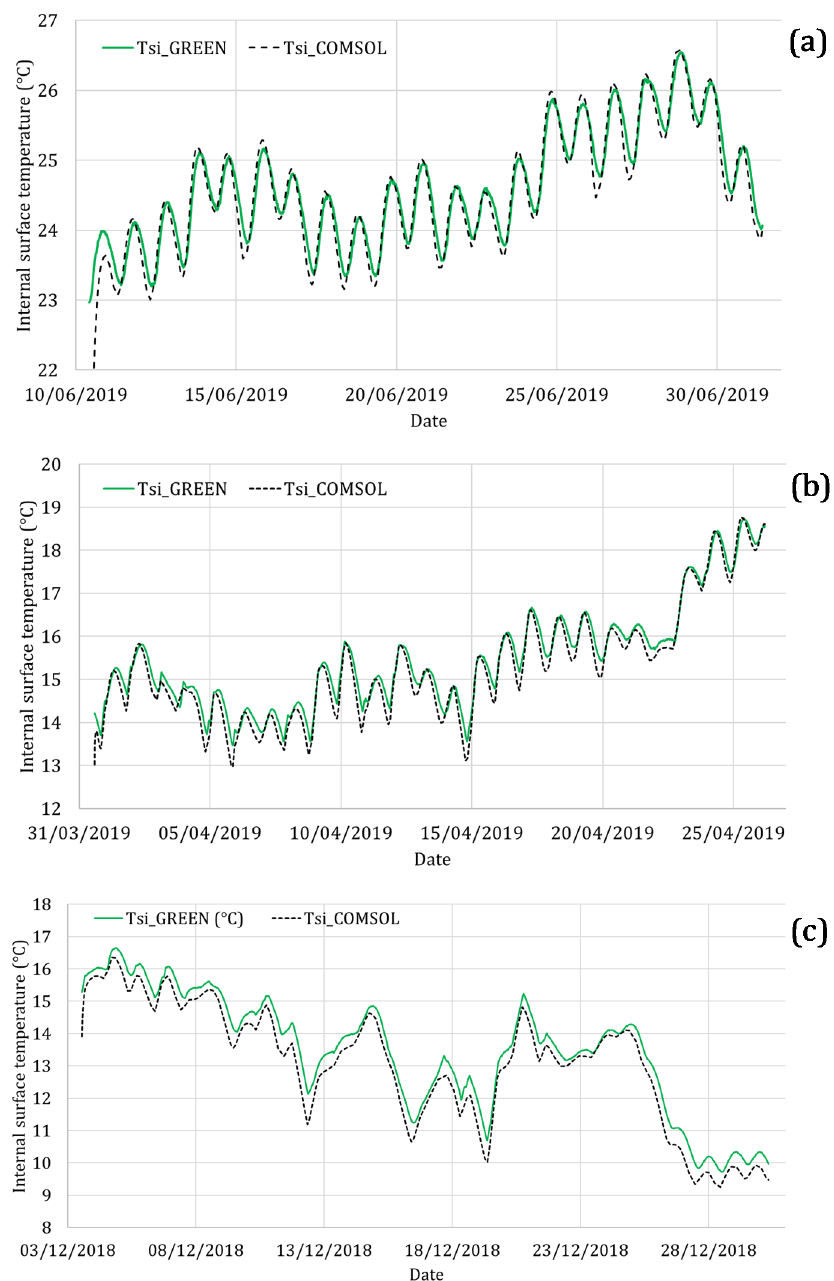
Figure 9. Green roof equivalent model. Comparison between measured and simulated internal surface temperature: summer ( a ); middle season ( b ); winter ( c ).